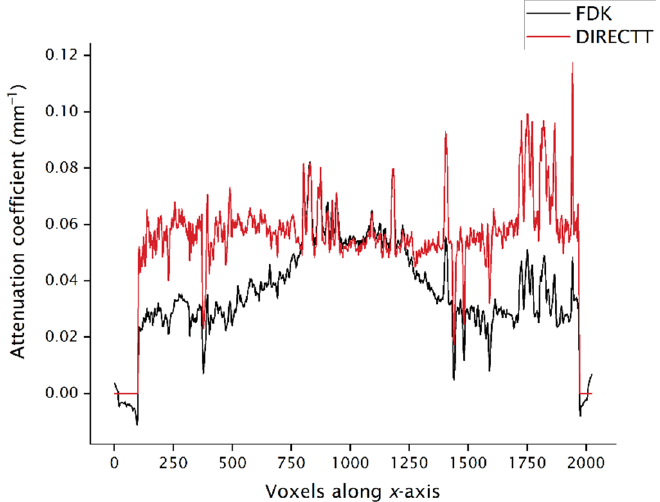
Figure 7. Profile along the x -axis of the attenuation coefficient values of the first slice shown in both Figures 1 and 5.